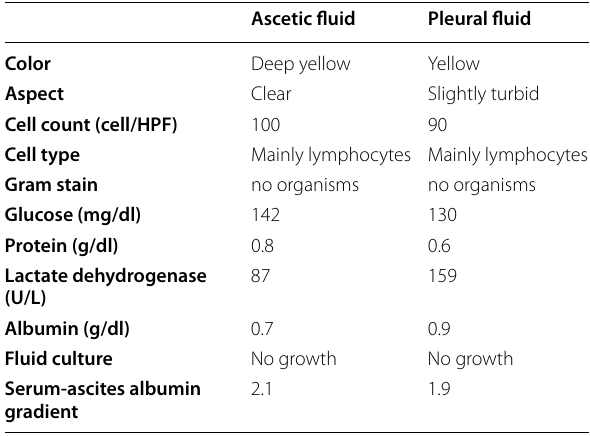
Table 2 Analysis of aspirated ascetic and pleural fluid